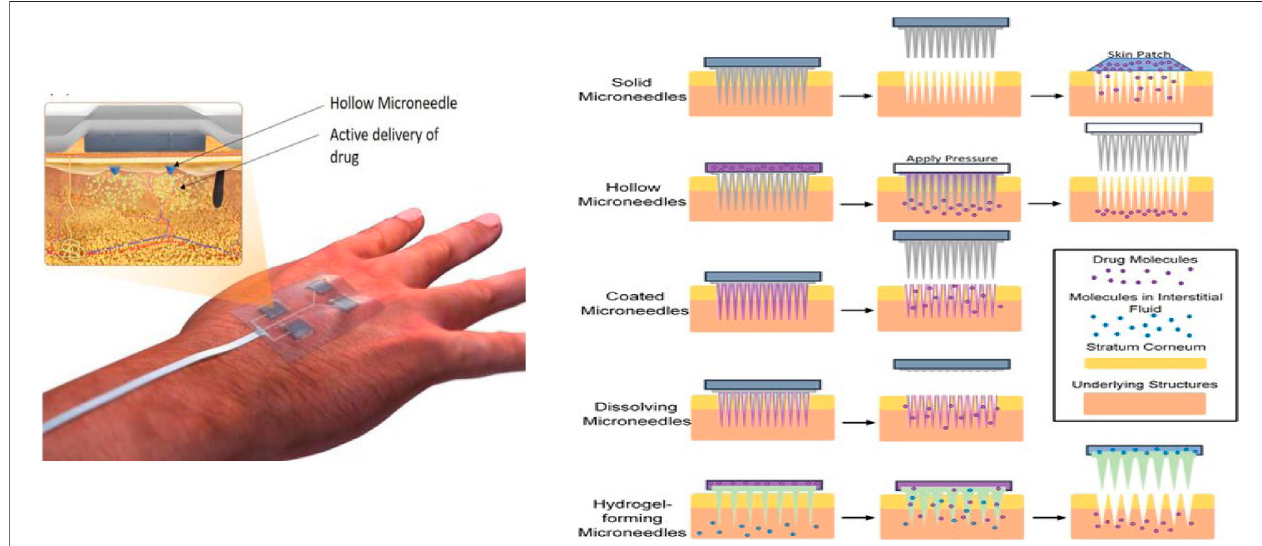
FIGURE 5 | Application of smart microneedle hydrogel used in wound healing.